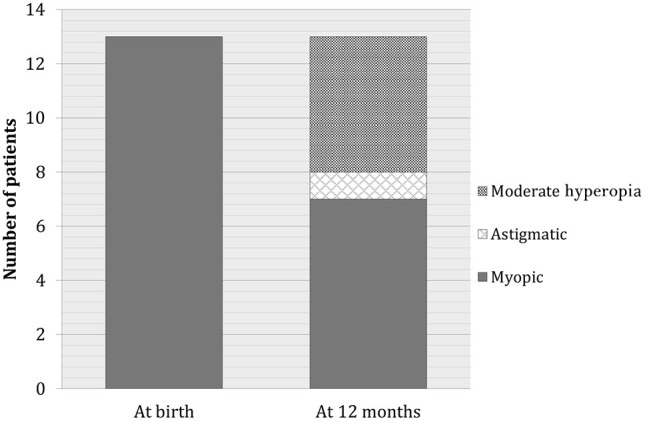
Evolution of myopia during follow-up.